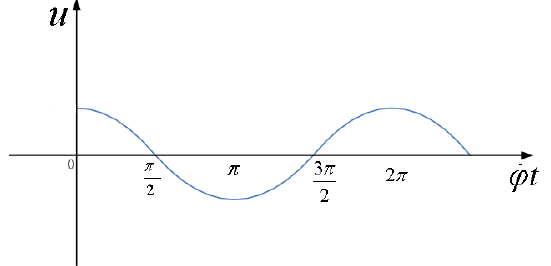
Figure 5. Output voltage waveform with a constant input angular velocity.